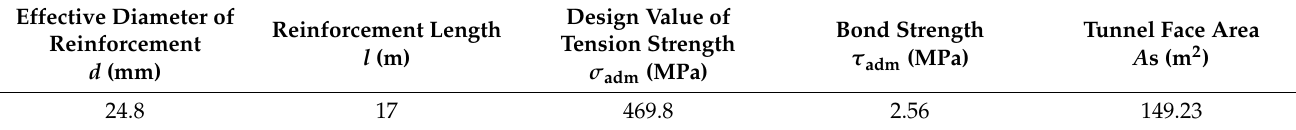
Table 8. Calculation parameters of GFPR face bolts.